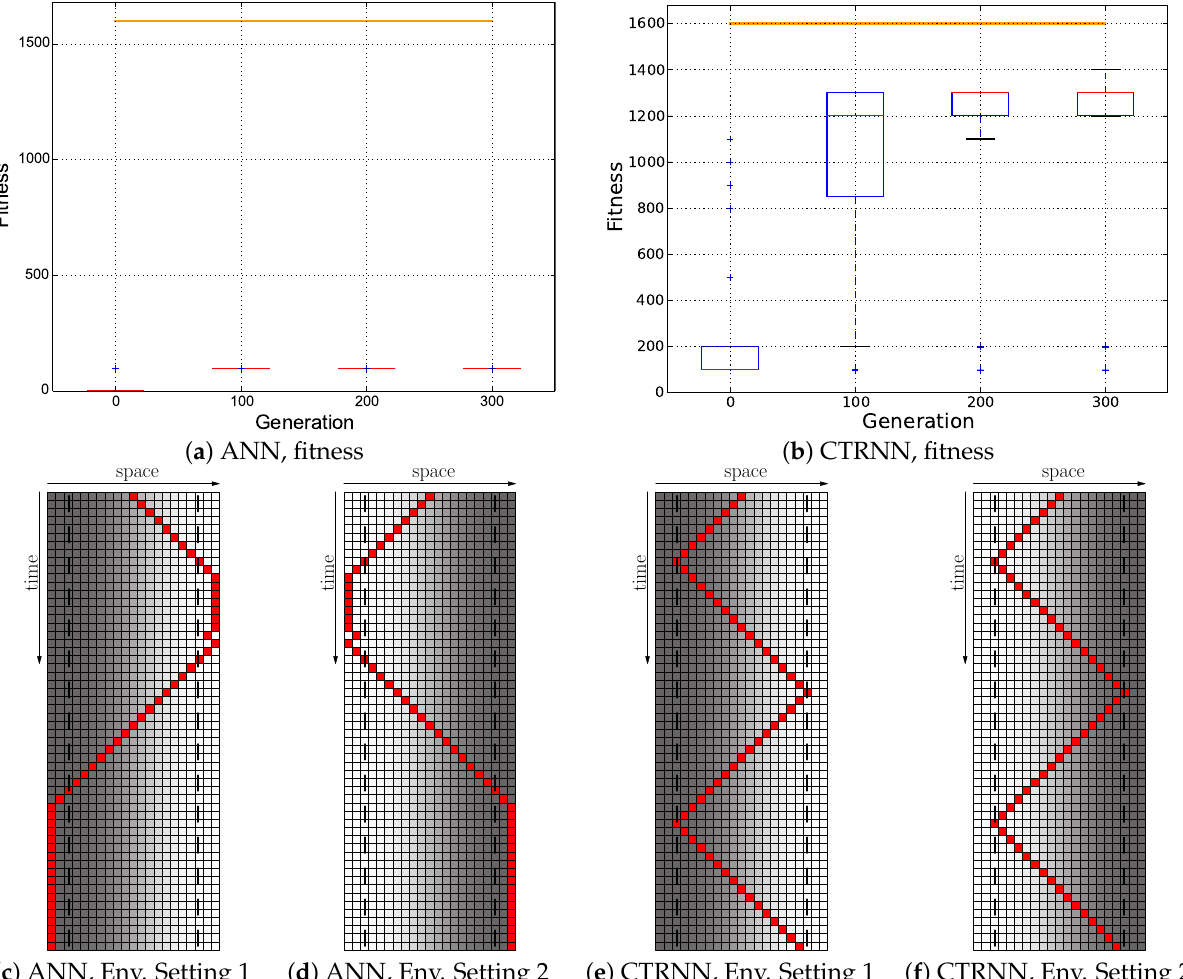
Figure 11. Evolutionary results of the Cumulative + Switch fitness regime: fitness = F ( 100,0.01,0 ) ; the minimum of both evaluations was used as the fitness value for each genome. Top row: fitness dynamics of the ANNs (left) and CTRNNs (right). The horizontal orange line indicates the maximum fitness achievable by a reactive Wankelmut controller, as it was achieved by the simple hand-coded controller. Bottom row: trajectory of the best performing genome of both controller types in both environments used in evolution (only the initial 56 time steps of 250 time steps are